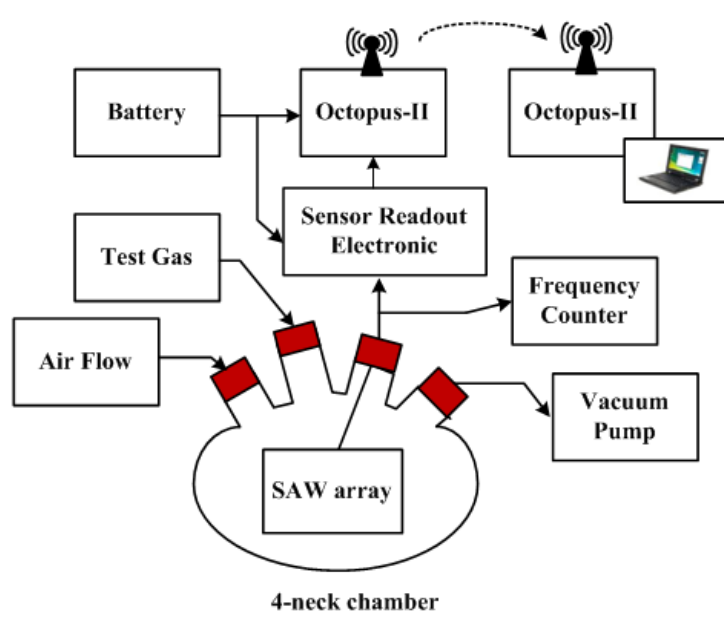
Figure 7. Gas experimental